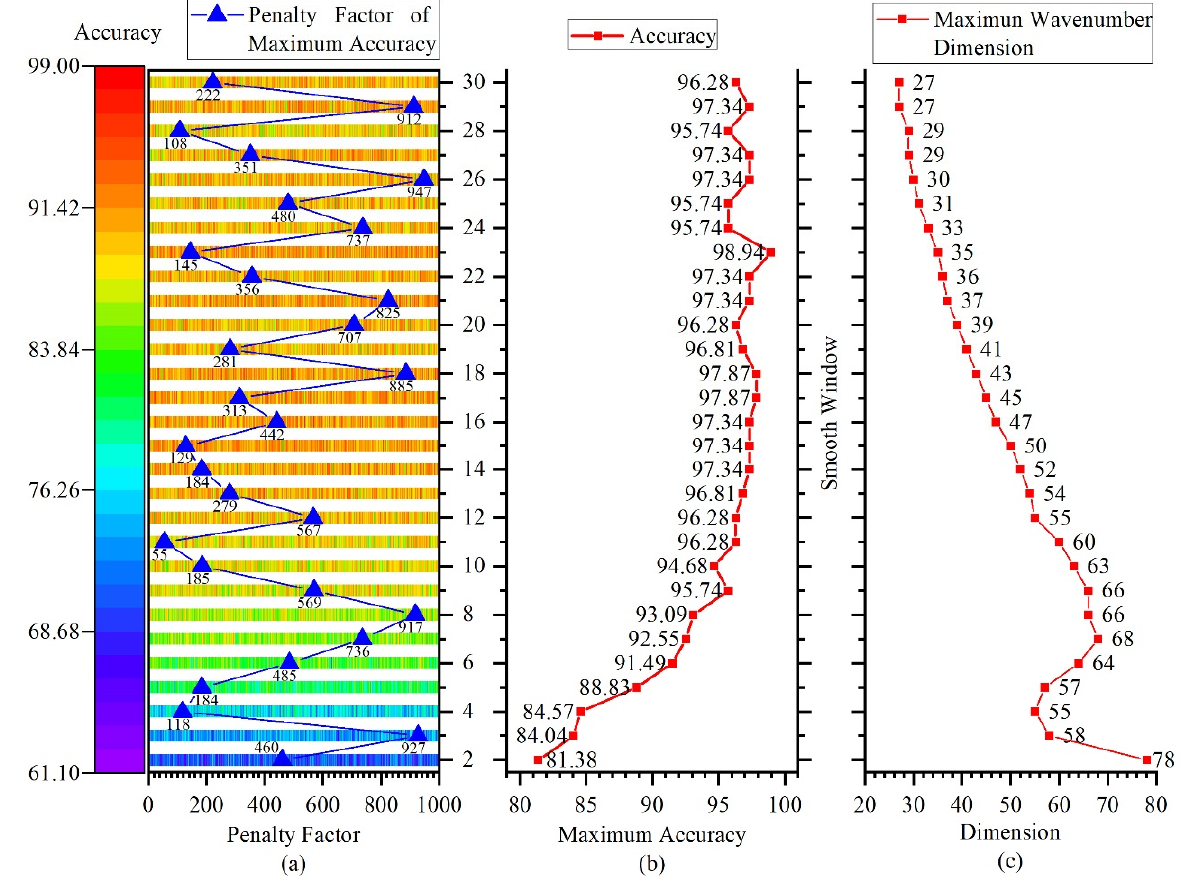
Figure 11. ( a ) Distribution of classification accuracy under different configurations of the smoothing window and penalty factor; ( b ) maximum classification accuracy of different smoothing windows; ( c ) characteristic wavenumber dimension of different smoothing windows.